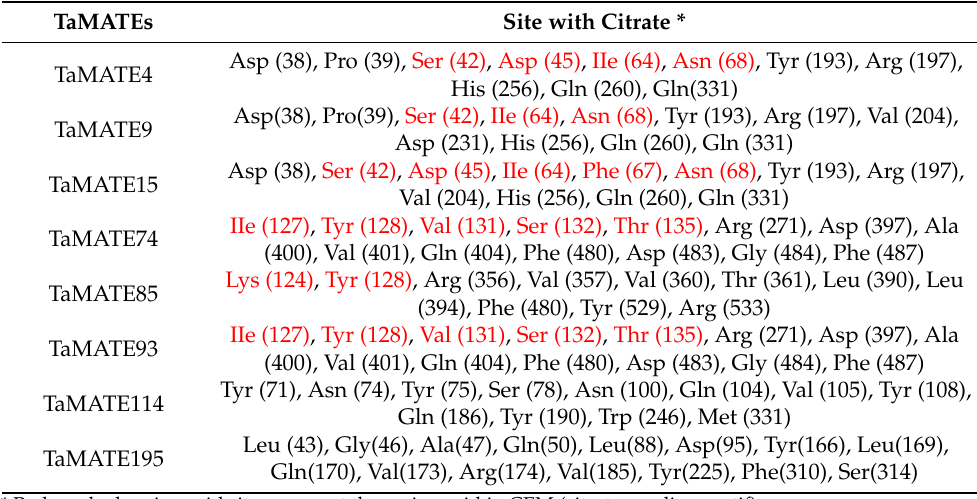
Table 1. The amino acid sites binding citrate in different TaMATE transporters. TaMATEs Site with Citrate